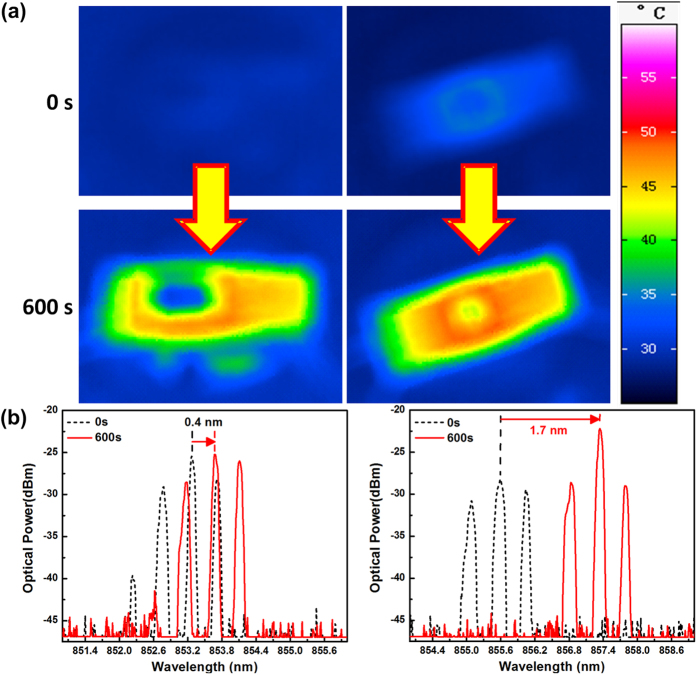
Experimental measurements of the 100-Gbps optical transceiver with and without brass block based metal heatsink.(a) The PCB bottom surface thermal images of the 100-Gbps optical transceiver with (left) and without (right) heat dissipation; (b) The VCSEL emitting spectra of the 100-Gbps optical transceiver with (left) and without (right) thermoelectric separation for one hour testing.